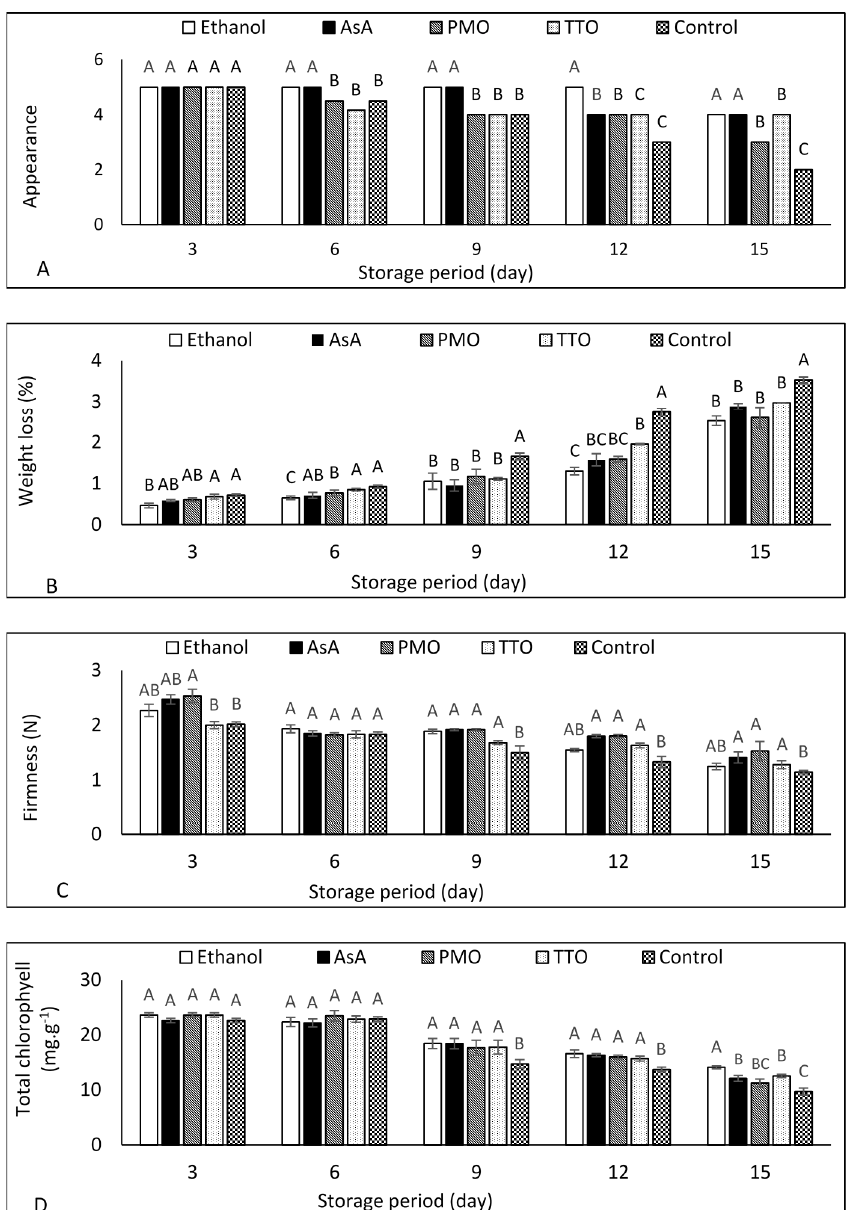
Figure 1. Effect of ethanol, ascorbic acid (AsA), peppermint oil (PMO), and tea tree oil (TTO) on ( A ) appearance, ( B ), weight loss, ( C ) firmness, and ( D ) total chlorophyll of fresh-cut green bean pods stored at 5 °C for 15 d. Different letters indicate significant differences ( p < 0.05) using the Tukey test at every storage point. Data are means of three replicates. Vertical bars represent standard error.